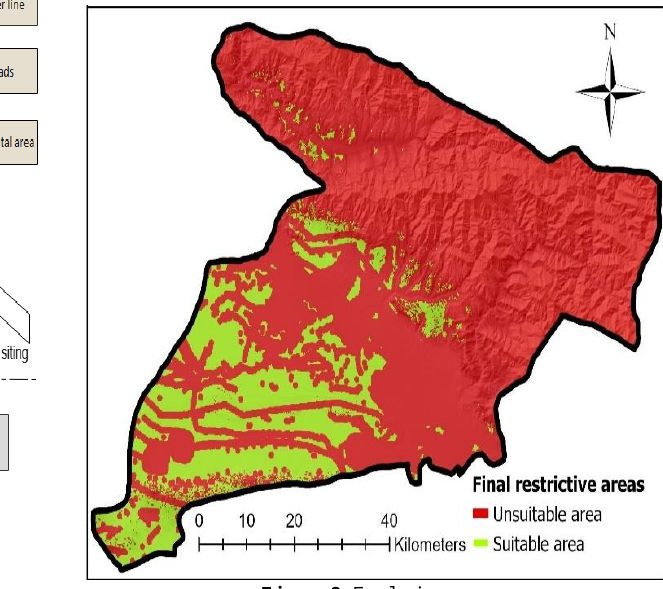
Figure 2 . Methodology of the study.